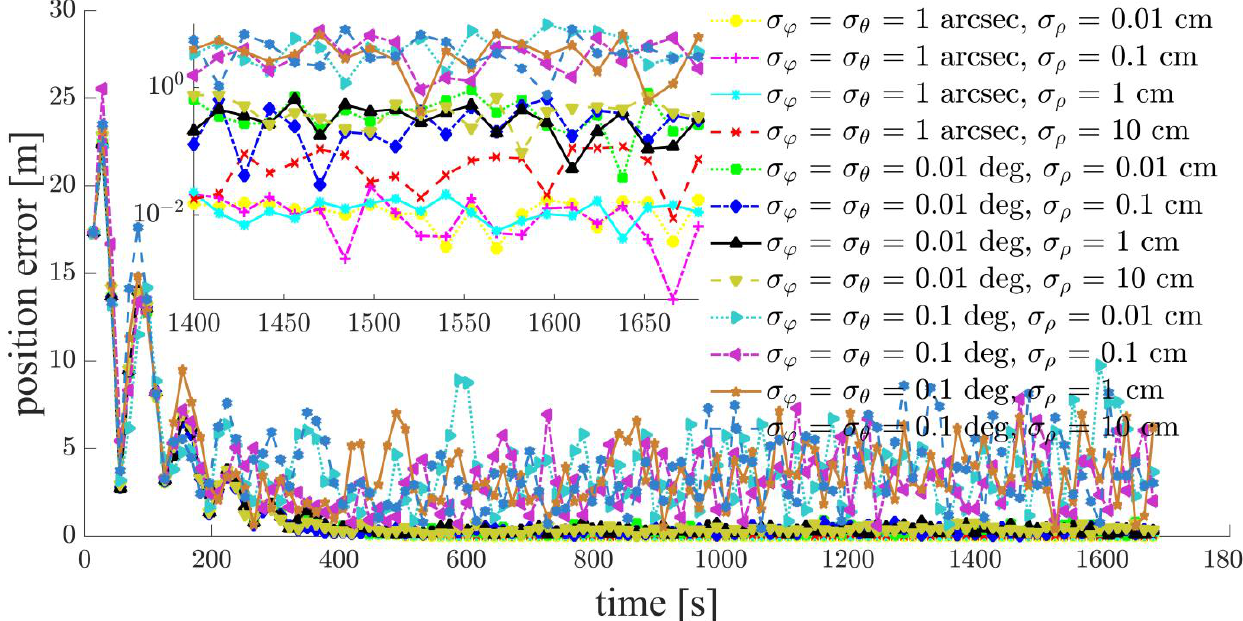
Figure 16. Relative navigation errors of 𝑆 6 (simulated scenario: Case d, space-circle formation radius of 1 km).